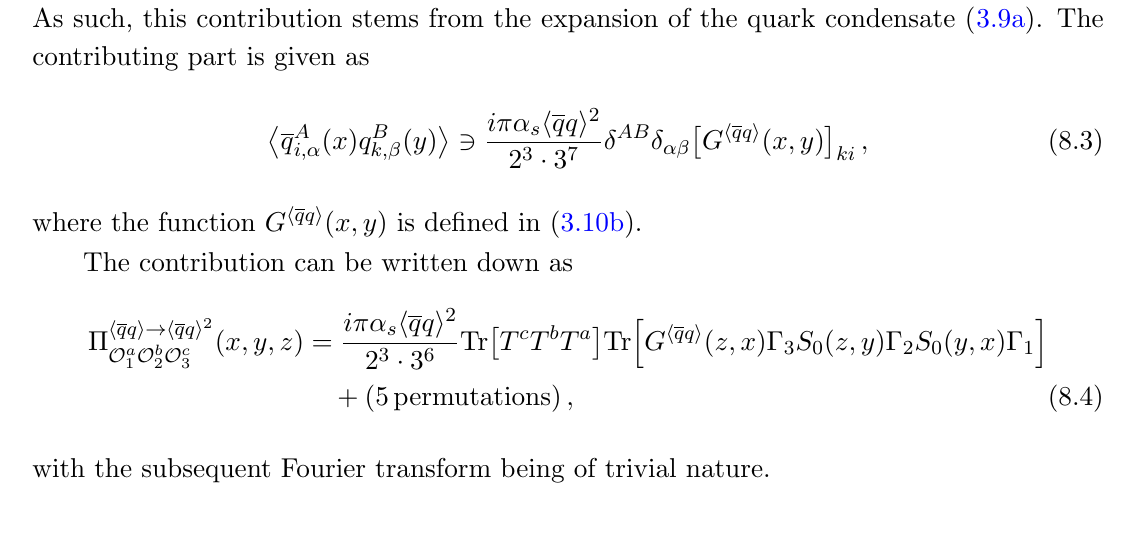
As such, this contribution stems from the expansion of the quark condensate (3.9a).